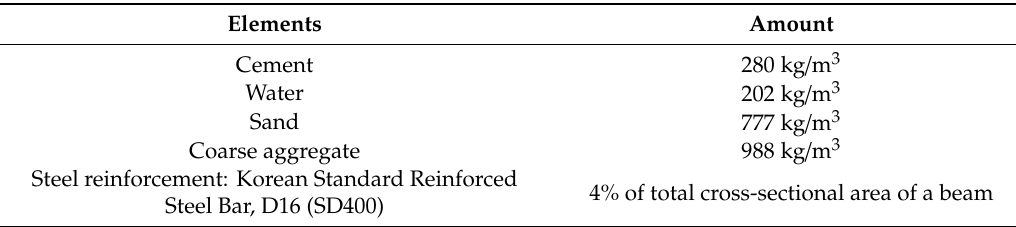
Table 1. Elements of the 24 MPa concrete beams used in the experimental